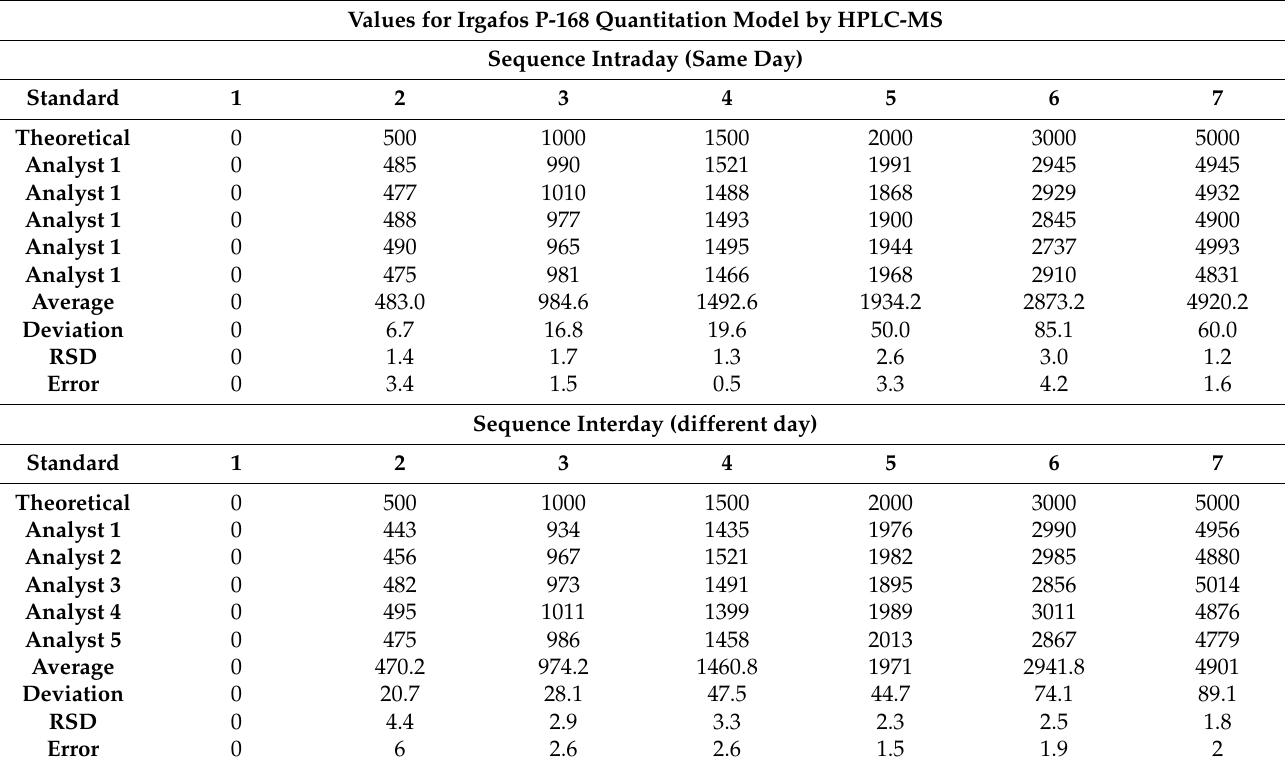
Table 1. Irgafos P-168 repeatability and reproducibility calibration curve data compilation. Values for Irgafos P-168 Quantitation Model by